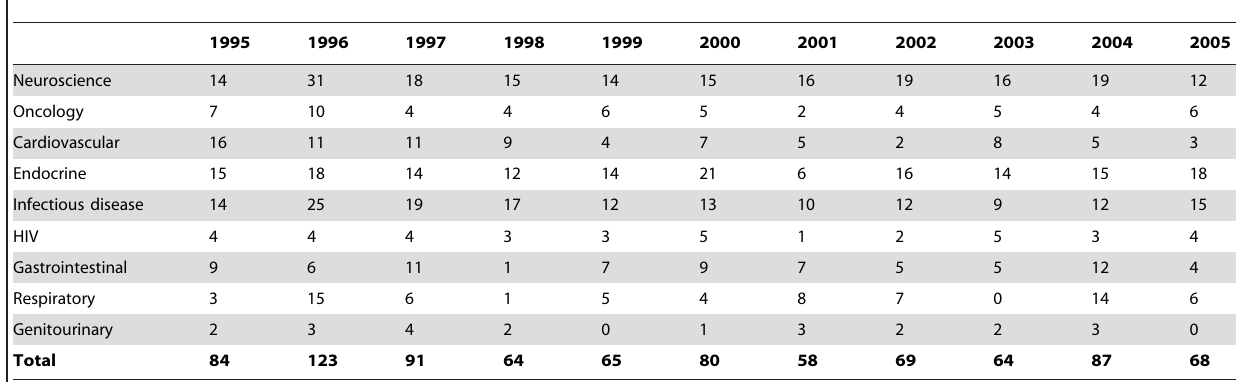
Table 2. Total Number of Drugs Approved by US Food and Drug Administration by Therapeutic Area, 1995–2005.